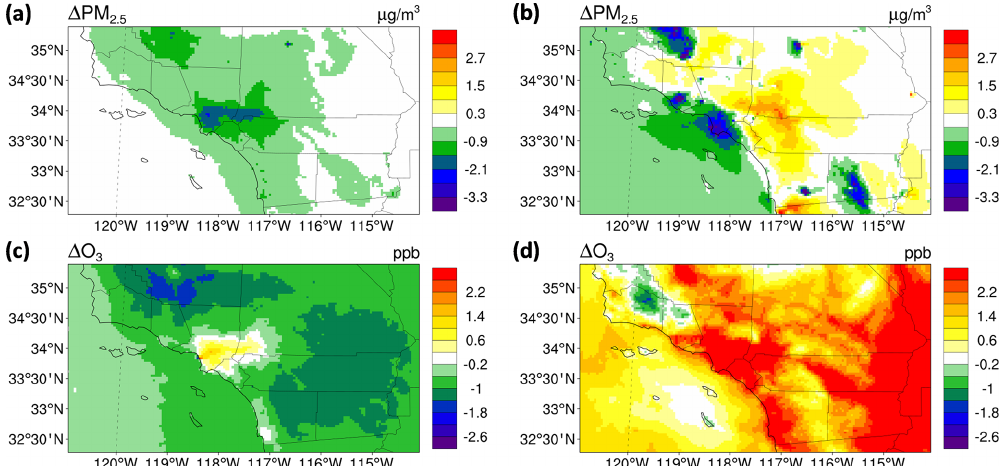
Figure 6. Spatial distributions of the emission reductions and meteorology condition effects on air pollutants. (a, c) Emission reductions and (b, d) meteorology variations in (a, b) PM 2 . 5 and (c, d) MDA8 O 3